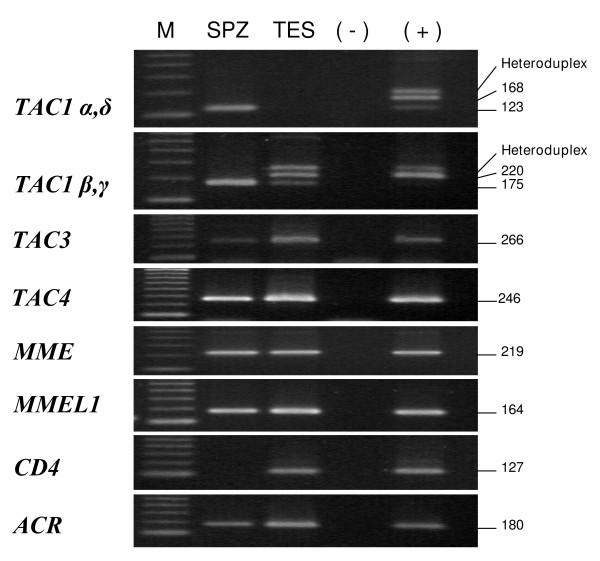
Gene expression of tachykinin precursors, neprilysin (MME) and neprilysin-2 (MMEL1) in human sperm (SPZ) and testis (TES). In human sperm, the specific bands corresponding to TAC1 γ and δ isoforms, TAC4 and MME were only detected after cDNA reamplification. Acrosin (ACR) was present in sperm and testis cDNA while CD4 was only detected in testis. (+), positive control showing the expression of all genes in a pool of cDNAs from twenty different human tissues. (-), negative control with no RNA in the reverse transcriptase reaction; M, molecular size standards. The figure is representative of results in 6 pools of sperm samples from 8 different donors.